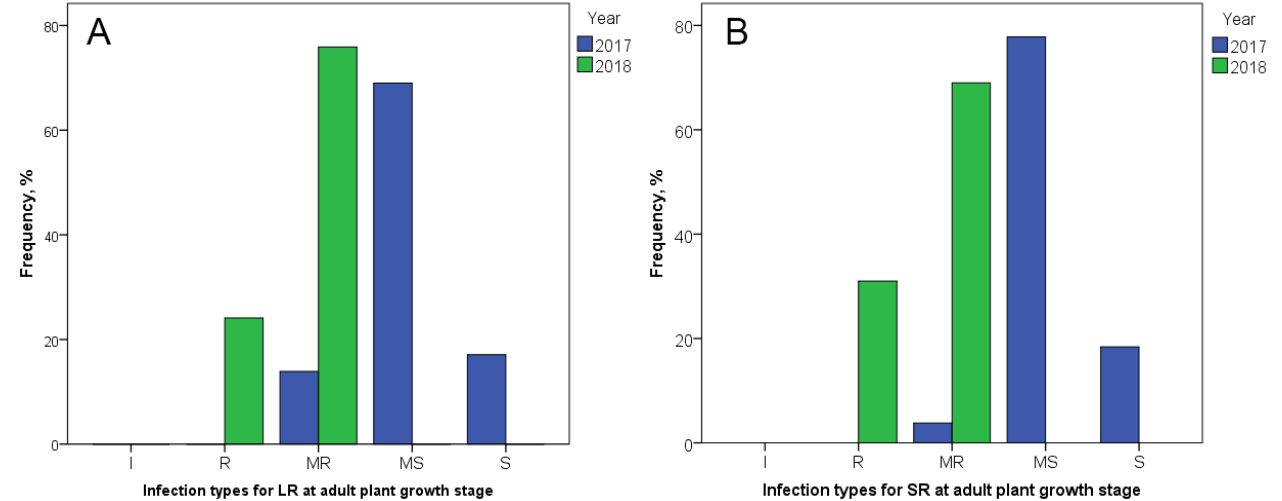
Figure 2. Infection types among 193 tetraploid wheat cultivars and breeding lines to ( A ) Puccinia triticina Eriks. (LR) and ( B ) Puccinia graminis f. sp. tritici (SR) at the adult plant stage in the field of Karabalyk agricultural experimental station in 2017 and 2018.